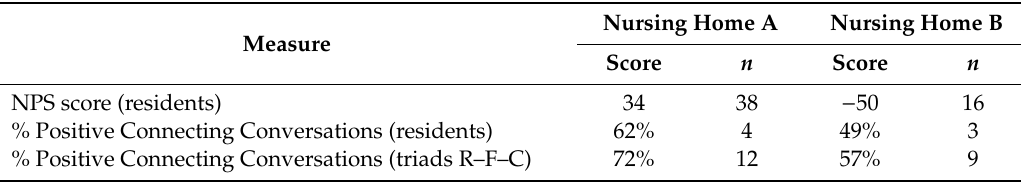
Table 6. NPS score and Connecting Conversations %-positive.